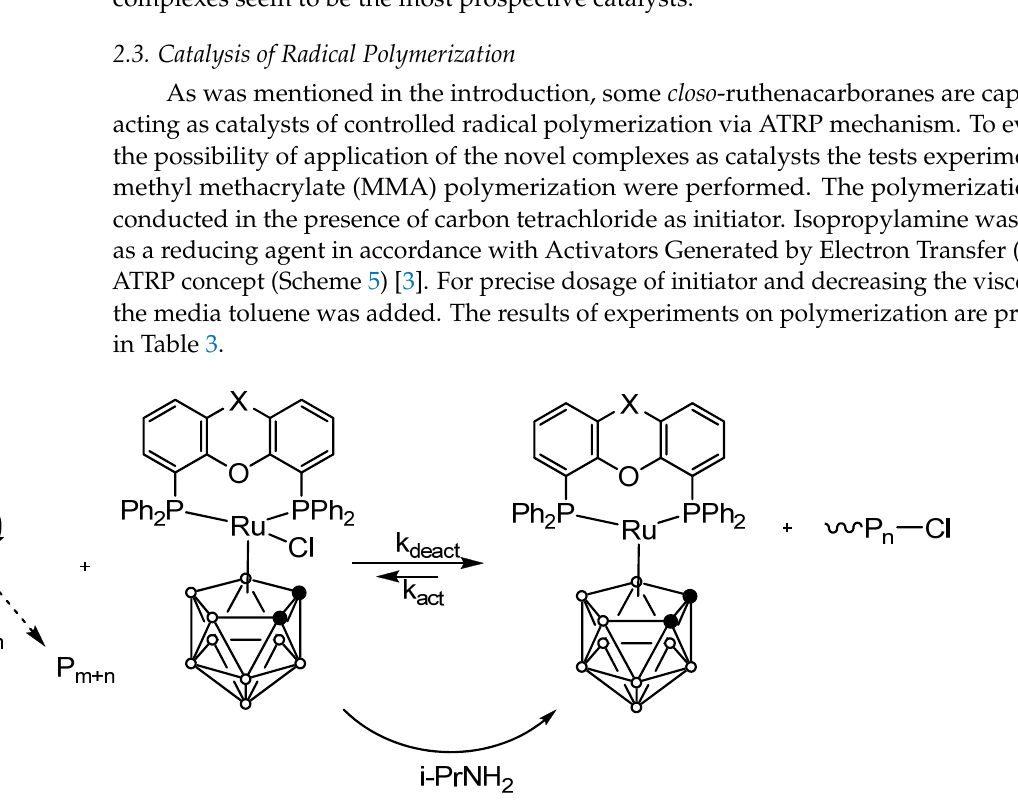
( b ) Figure 3. CVA curves recorded for ( a ) 17-e complexes 2 , 4 , 7 ; ( b ) 18-e complexes 3 , 5 , 8 . Complexes 3 and 8 are characterized by redox transitions at 286 and 348 mV versus ferrocene respectively. Oxidation of these compounds to Ru(III) species proceeds